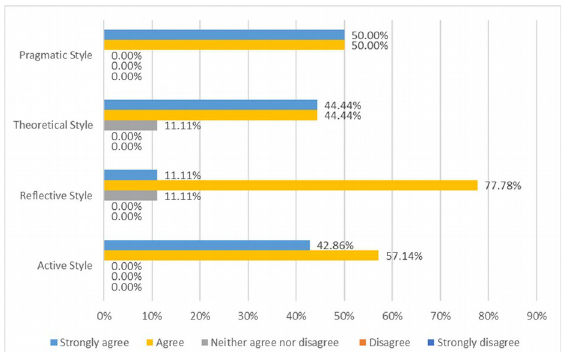
Figure 12. Learning is more active and experiential